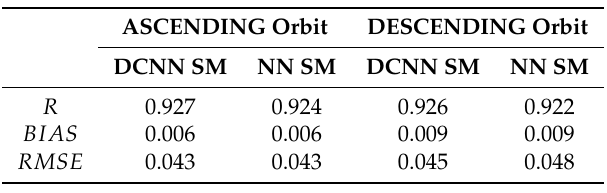
Table 4. Spatial correlation between DCNN/NN SM and ERA-interim SM in testing phase from 1 January to 31 December 2016. Data from ascending and descending orbits are processed separately.